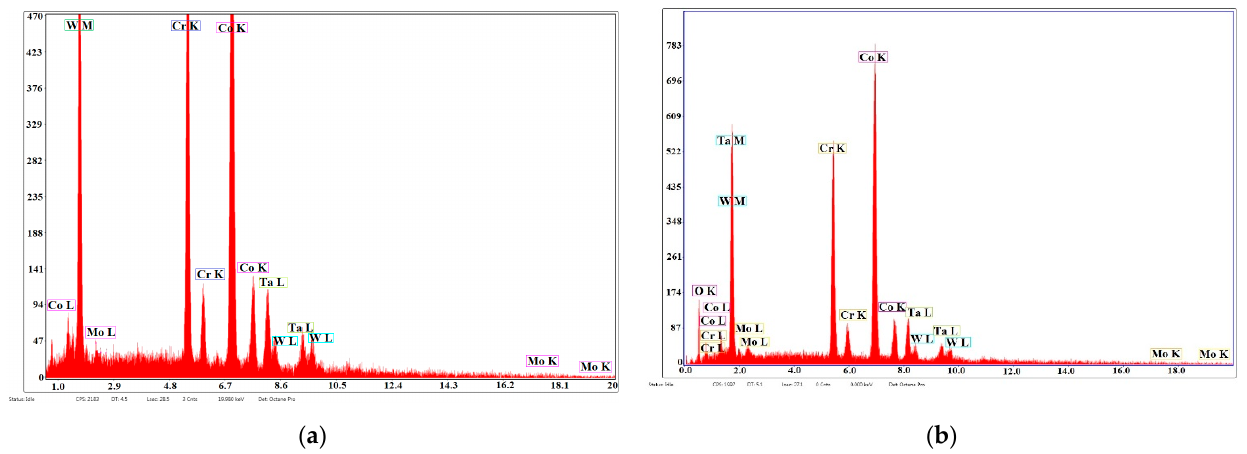
Figure 3. EDS analysis of sintered samples of Co-Cr alloy fabricated via DMLS and coated with a thin film of Ta 2 O 5 using an e-gun for: ( a ) sample S1 with post-treatment and ( b ) sample S2 without post-treatment.